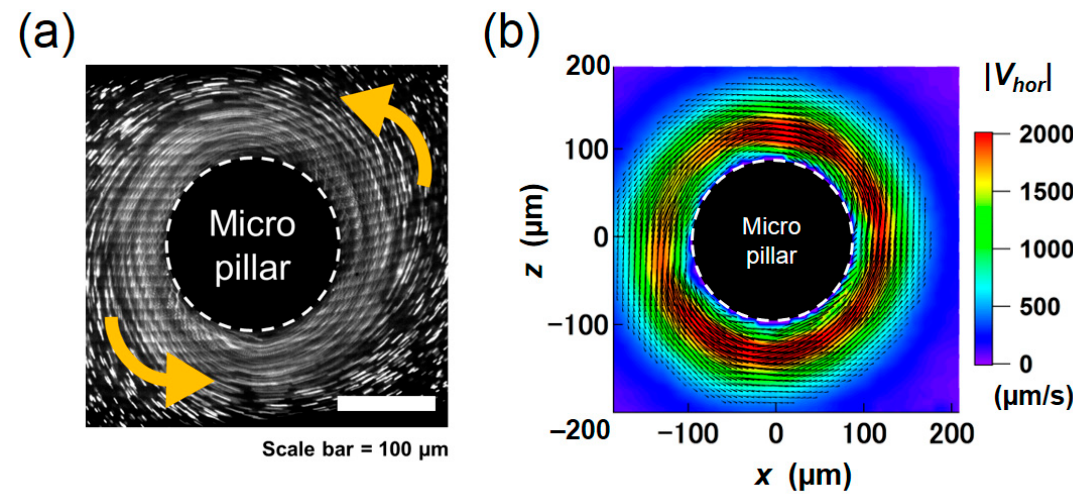
Figure 8. ( a ) Raw image of fluorescent tracer beads overlaid for sixty cycles. ( b ) 2D vector plot of the averaged velocity flow field obtained from PIV measurement.